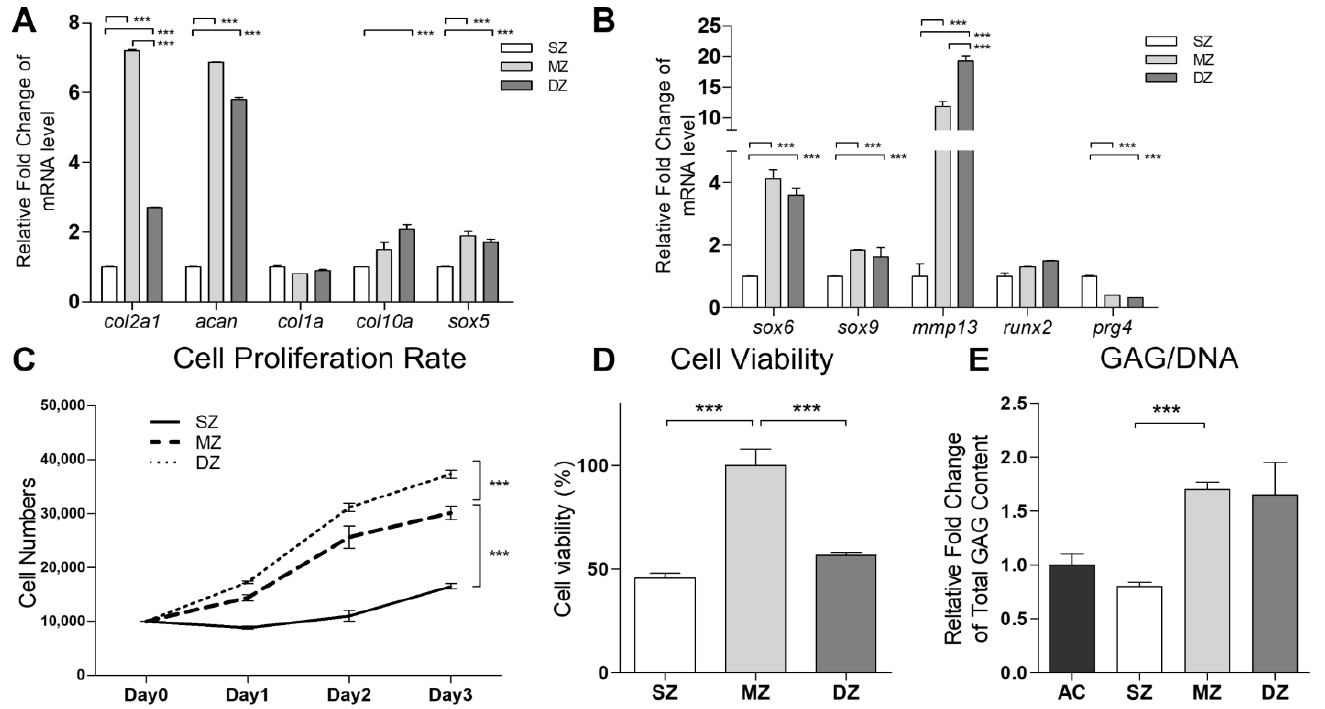
Figure 1. Functional properties of separation of superficial zone (SZ), middle zone (MZ), and deep zone (DZ) of chon- drocytes. The porcine articular chondrocytes by discontinuous Percoll gradient. ( A , B ) The mRNAs of col2a1 , Acan , col1a1 , col10a1 , sox5 , sox6 , sox9 , mmp13 , runx2 , prg4 , and gapdh among SZ, MZ, and DZ of chondrocytes were analyzed by real time PCR. The modulation of mRNA expression was expressed relative to the SZ after normalization to the gapdh signal. ( C ) Cell proliferation rates of SZ, MZ, and DZ of chondrocytes were determined by counting the cell numbers for 3 days. ( D ) The SZ, MZ, and DZ of chondrocytes were cultured in the monolayer for 72 h. The cell viability was then detected using an MTT assay. ( E ) Total glycosaminoglycan (GAG) content was measured in monolayer culture. (***, p < 0.001).